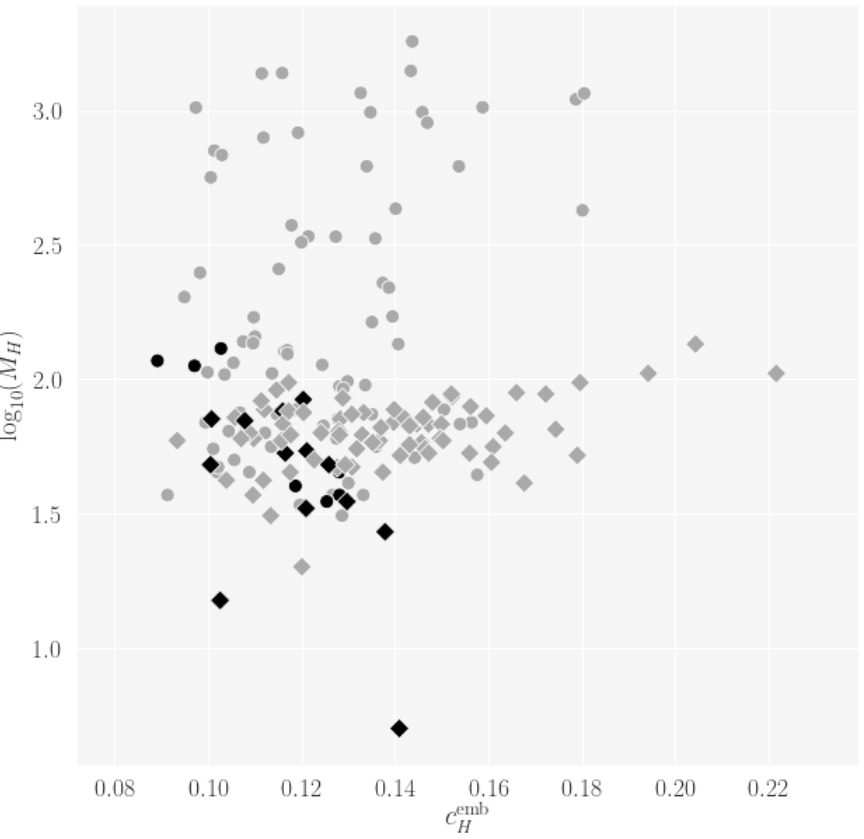
Figure 6. Scatterplot visualizing a relation between topic interpretability, term specificity, and coherence. LDA topics are represented through diamonds, term community topics through circles. Topics that the evaluators scored with grade 3 or higher are colored gray; black color marks the topics that were found difficult to interpret. The topics are positioned vertically according to the logarithm of the number of its highly ranked terms M H and horizontally according to the embedding coherence c emb of the highly ranked H